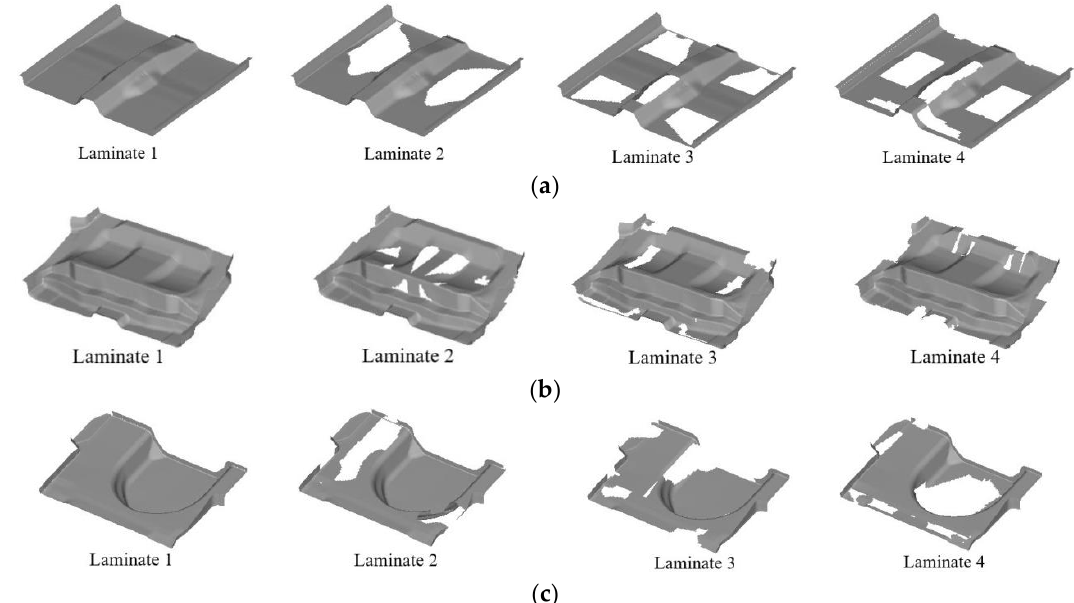
Figure 19. Layer block shape corresponding to 45° super layer: ( a ) Front floor; ( b ) Middle floor; ( c ) Rear floor.